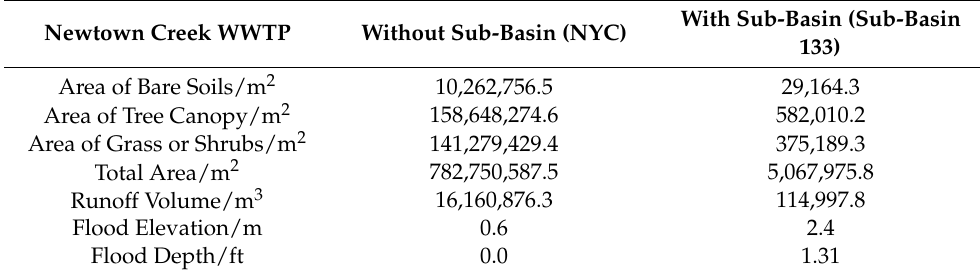
Table 9. Calculated runoff volume with and without sub-basins.